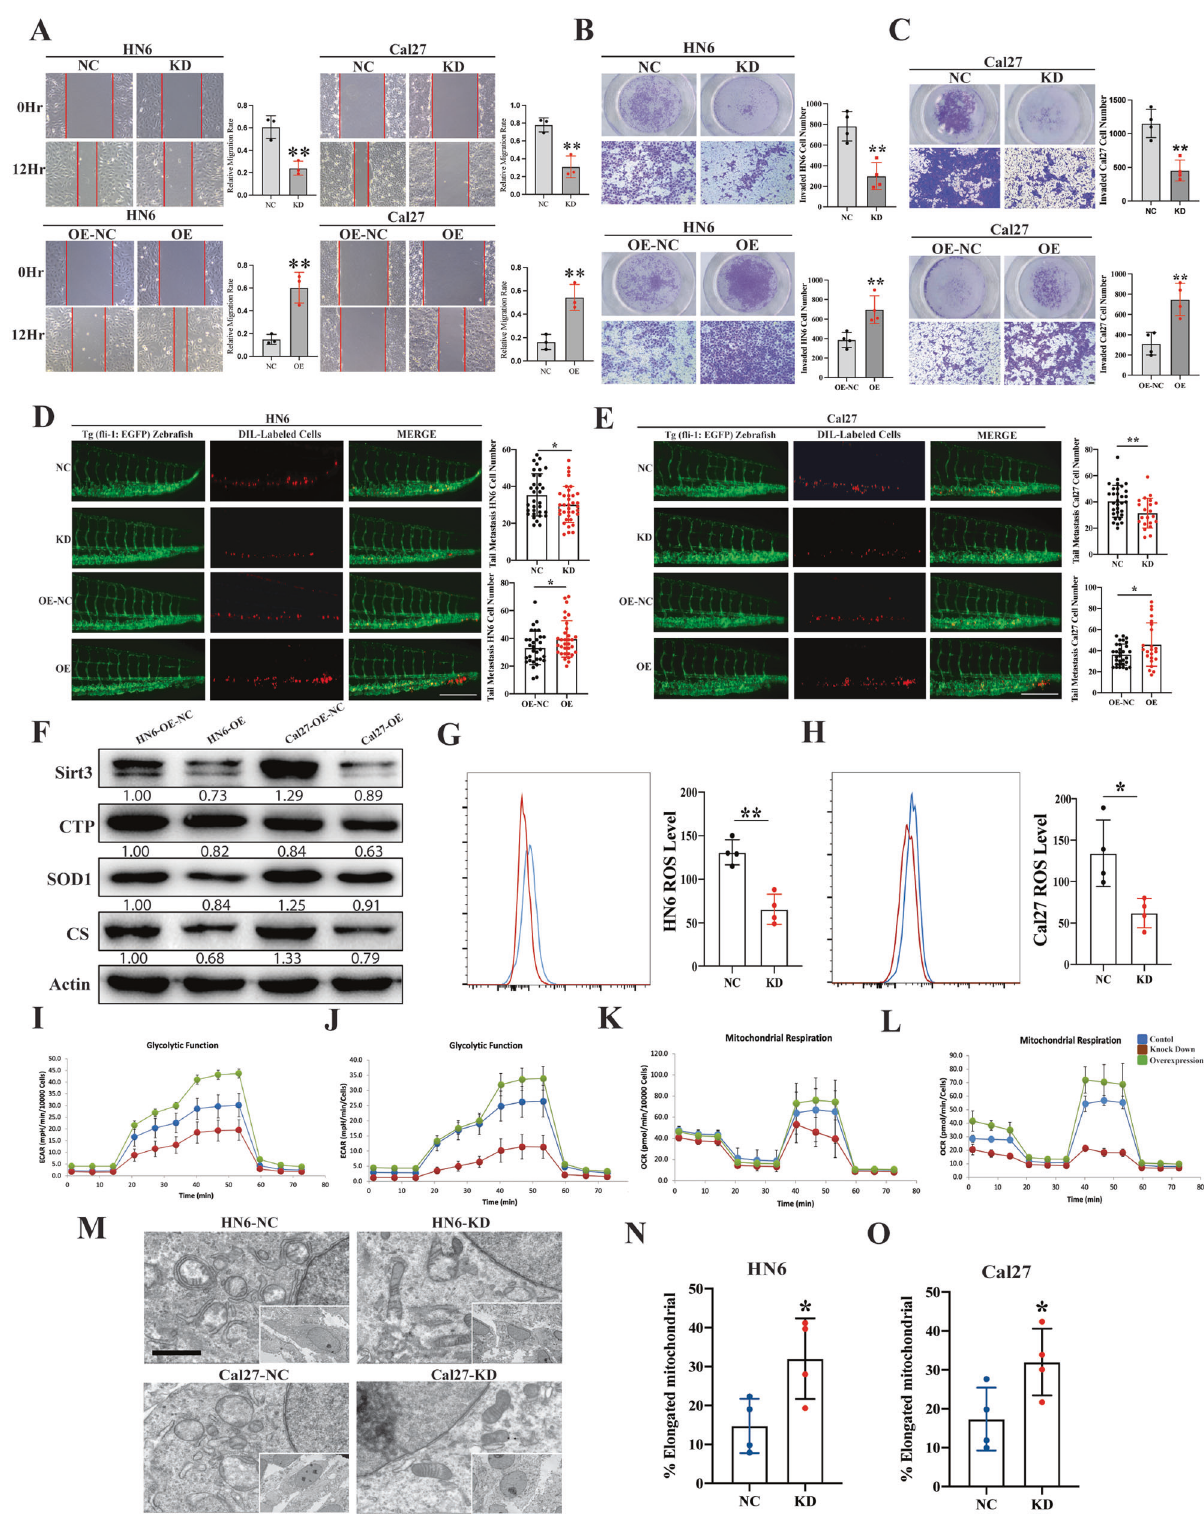
CYTOR-HNRNPC-ZEB1 axis promotes the migration and invasion of oral cancer cells through regulating mitochondrial metabolism and glycolysis (Fig. 8). By packaging CYTOR-targeting siRNAs into NMOFs, we provide a powerful example of a nanoscale tumor- speci fi c drug delivery strategy that confers anti-metastatic effects through targeting a